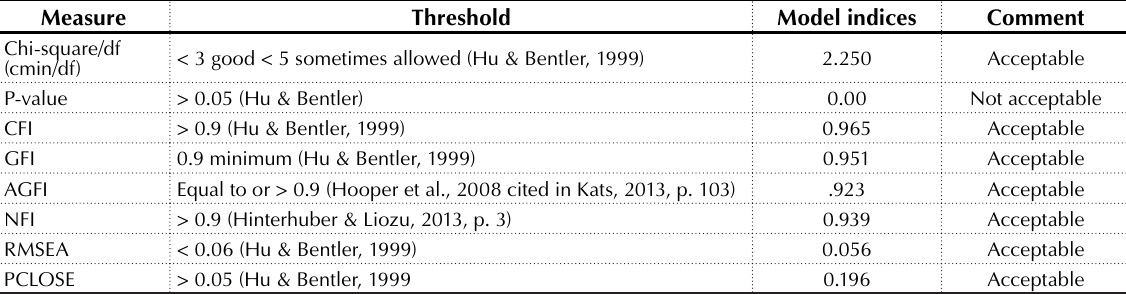
Table 5. Model fit indices for SERVPERF dimensions